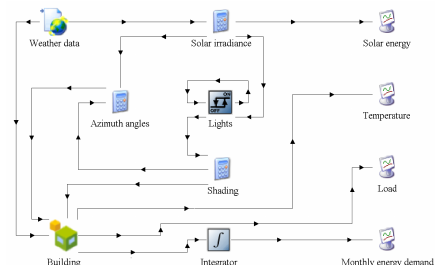
Figure 1. Trnsys17 model used for the evaluation of the energy demand of the building